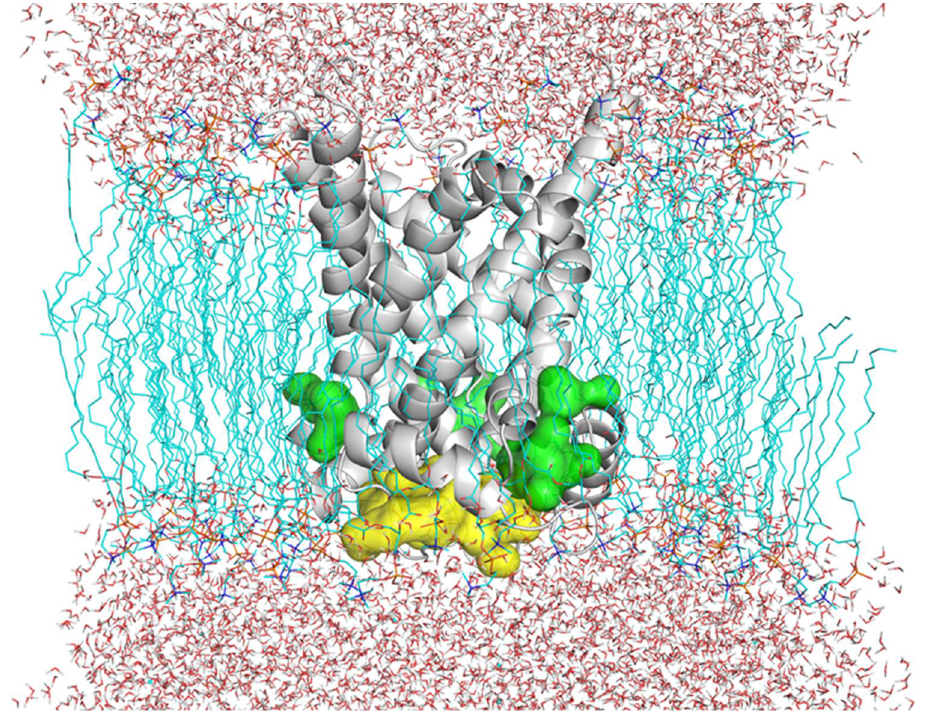
Figure 6. The OGC carrier structure within the inner mitochondrial membrane (displayed as cyan sticks) is represented by the gray cartoon. Water molecules above and below the represented membrane are also displayed as white and red sticks. The predicted binding sites facing the membrane, resulting from the Sitemap analysis, are represented by green surf. The predicted binding site, facing the mitochondrial matrix, is represented by yellow surf. The highlighted binding sites facing the membrane were excluded from the following docking analyses because they were not accessible for the substrate.